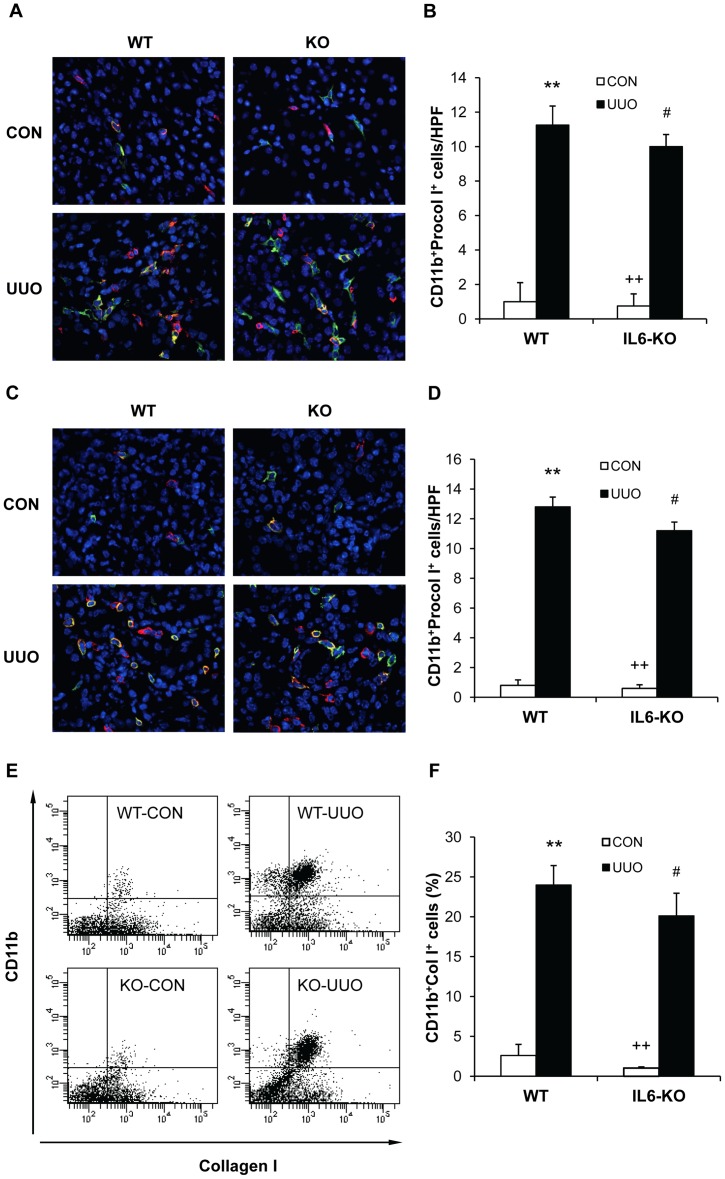
Effect of IL-6 deficiency on the accumulation of bone marrow-derived fibroblast precursors in the kidney after UUO.
A. Representative photomicrographs of kidney sections from WT and IL-6 KO mice 5 days after UUO stained for CD11b (red), procollagen I (green), and DAPI (blue). B. Quantitative analysis of CD11b+ and procollagen I+ fibroblasts in the kidney of WT and IL-6 KO mice 5 days after UUO. ** P<0.01 vs WT control, #
P>0.05 vs WT-UUO, and ++
P<0.01 vs KO-UUO. n = 4 per group. C. Representative photomicrographs of kidney sections from WT and IL-6 KO mice 1 week after UUO stained for CD11b (red), procollagen I (green), and DAPI (blue). D. Quantitative analysis of CD11b+ and procollagen I+ fibroblasts in the kidney of WT and IL-6 KO mice 1 week after UUO. ** P<0.01 vs WT control, #
P>0.05 vs WT-UUO, and ++
P<0.01 vs KO-UUO. n = 5 per group. E. Representative cytometric diagrams showing the effect of IL-6 deficiency on the accumulation of CD11b and collagen I dual positive fibroblasts in the kidney of WT and IL-6 KO mice 1 week after UUO. F. Quantitative analysis of CD11b and collagen I dual positive fibroblasts in the kidney of WT and IL-6 KO mice 1 week after UUO. ** P<0.01 vs WT control, #
P>0.05 vs WT UUO, and ++
P<0.01 vs KO UUO. n = 3 per group.